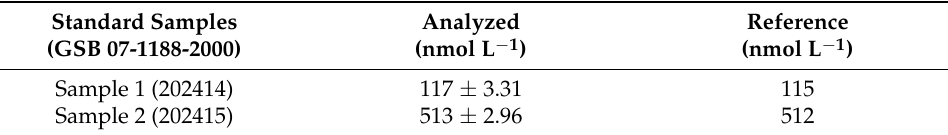
Table 1. Comparison of the determination results with the values of the environmental standard samples ( n =